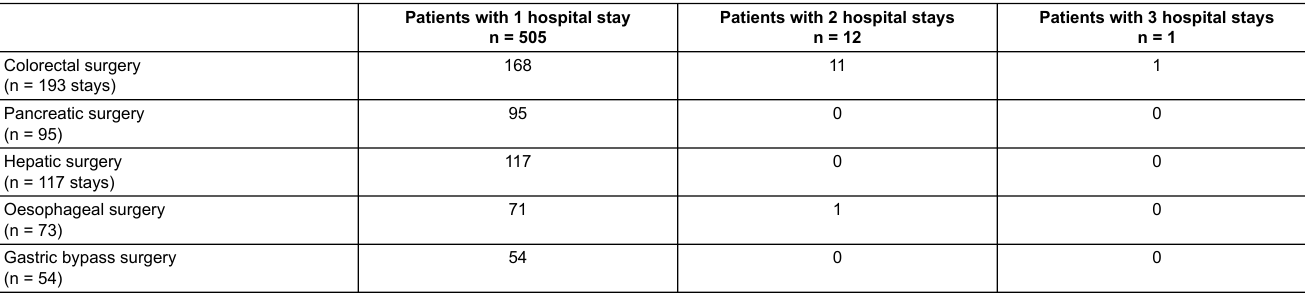
Table 2: Details of the 532 hospital stays.